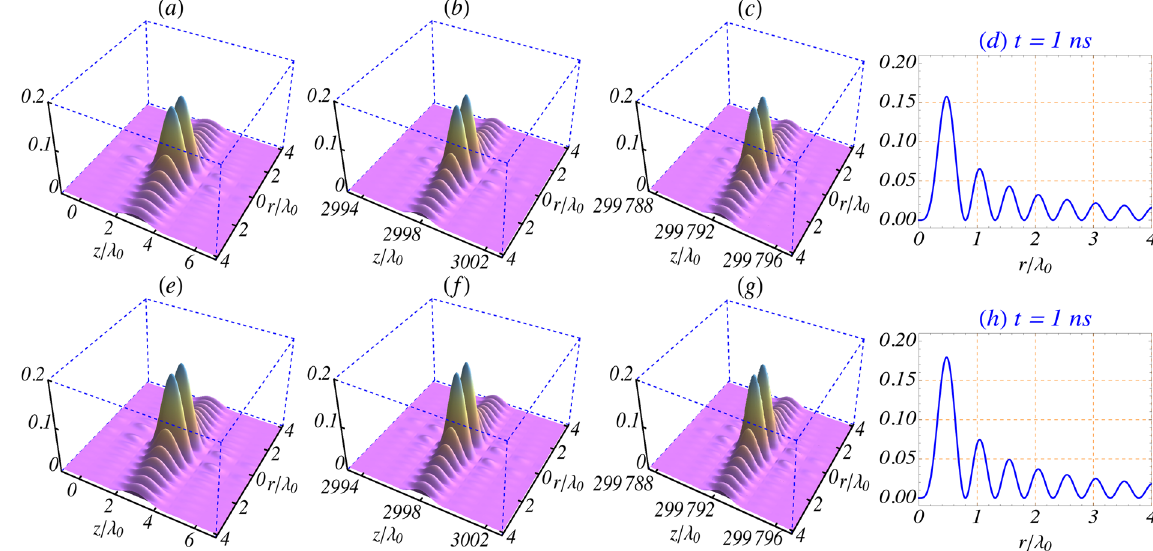
2 (0) , in the z − r plane, for the ultra- z 0